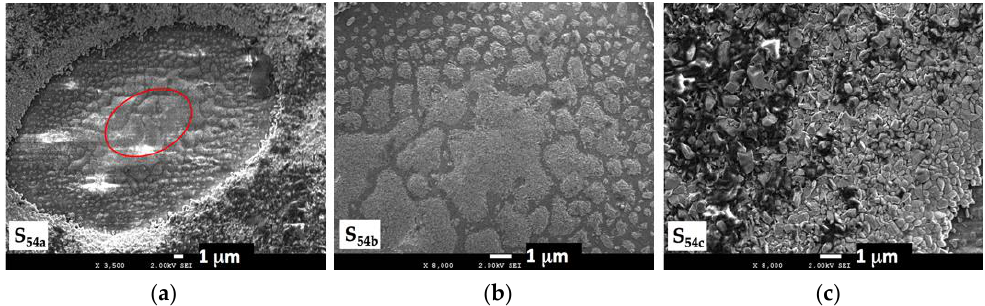
Figure 9. SEM micrograph for the irradiated spot S 54 at per-pulse laser fluence 3.6 mJ/cm 2 and 30 s exposure time. ( a ) S 54a is a close up of the crater; ( b ) S 54b shows a zoom in within the crater; ( c ) S 54c is a magnified image of the edge zone next to the crater.